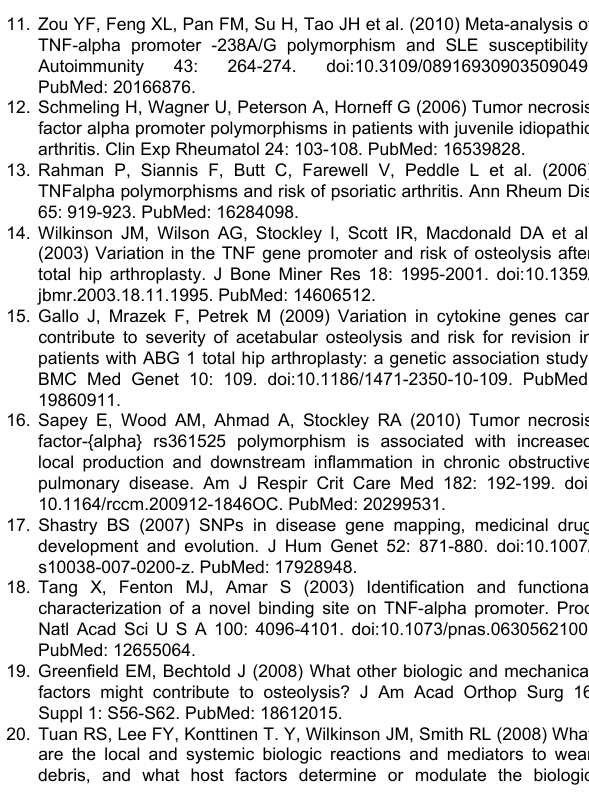
Figure S2. Reproducible knockdown of Thra and Thrb was achieved (n=3) in Raw 264.7 cells, as verified by gene specific Taqman qRT-PCR (ABI). Mean expression values (relative to beta-actin levels) were used and expressed as normalized to control treated (siNC) samples. Experimental conditions were identical to those, used in experiments that are presented in Figures